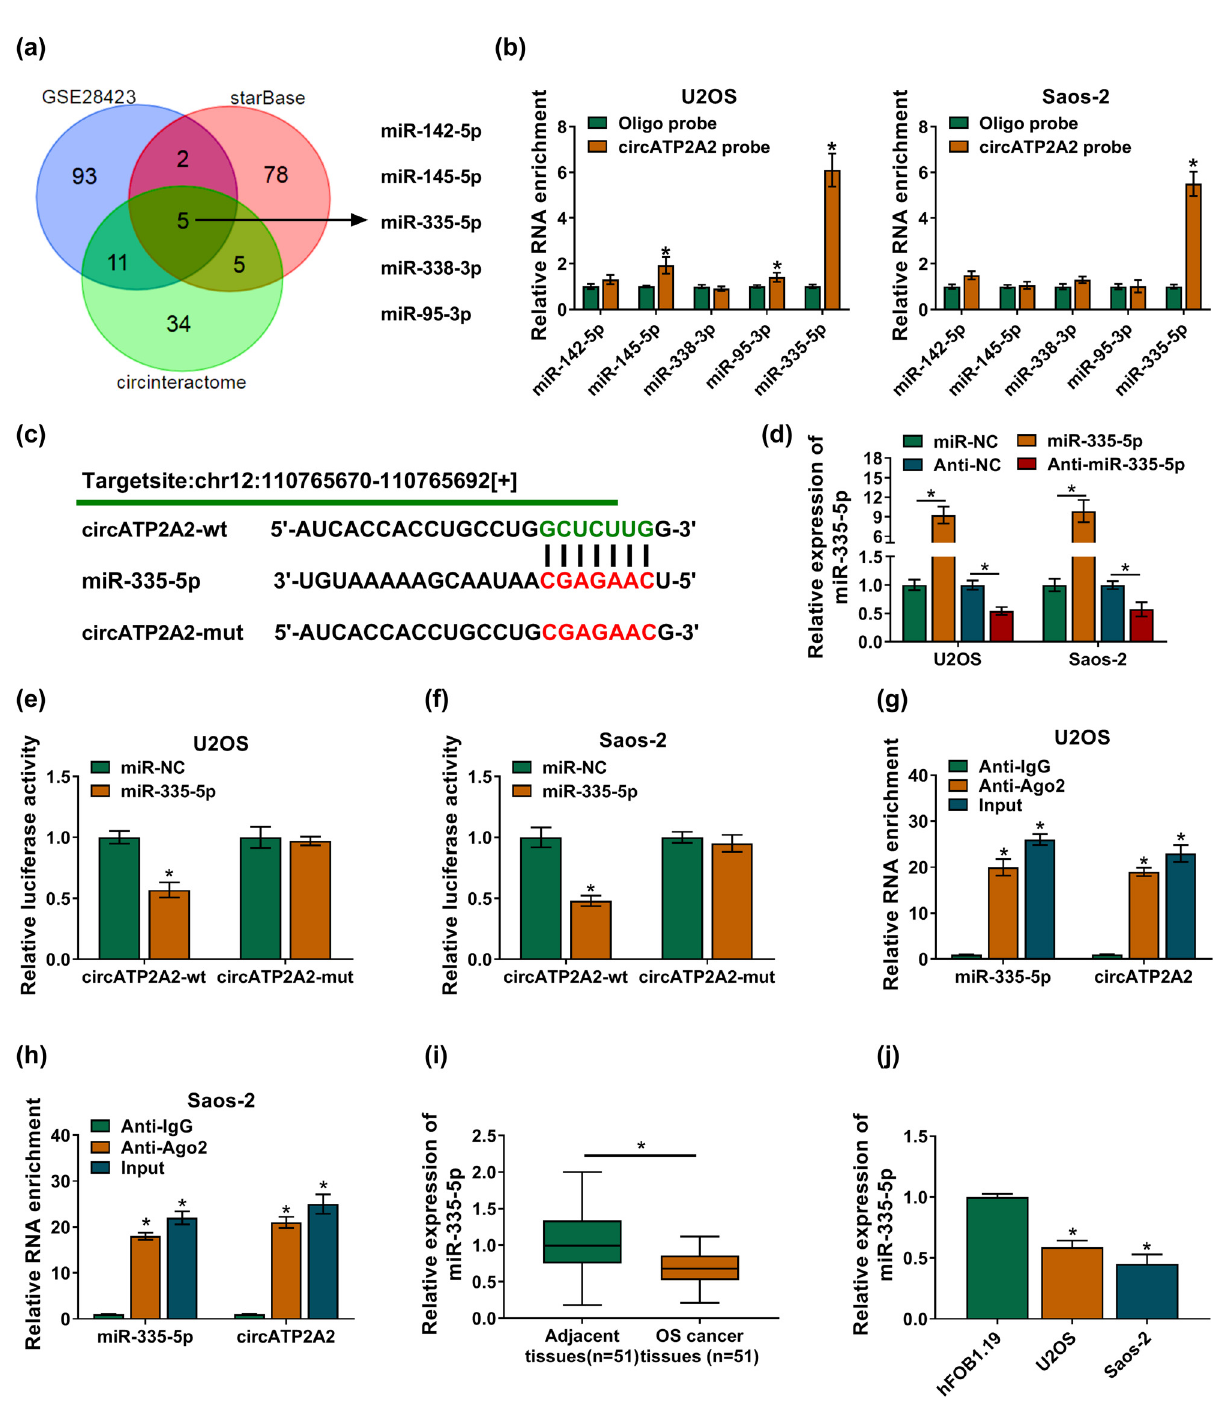
Figure 3: circATP2A2 was veri fi ed as a miR - 335 - 5p sponge. ( a ) The candidate miRs containing the putative binding sites of circATP2A2 were overlapped in circinteractome, starBase, and GSE28423 databases. ( b ) The abundance of candidate miRs in the oligo probe and circATP2A2 probe groups was detected by RT - qPCR. ( c ) The putative binding sites of circATP2A2 on the miR - 335 - 5p seed sequence. ( d ) The over - expression and interference e ffi ciencies of miR - 335 - 5p and Anti - miR - 335 - 5p were analyzed by RT - qPCR. ( e and f ) The luciferase activity of circATP2A2 - wt or circATP2A2 - mut reporter in OS cells was assessed by dual - luciferase reporter assay. ( g and h ) The enrichment of miR - 335 - 5p and circATP2A2 in co - immunoprecipitated in the anti - Ago2 and anti - IgG groups was analyzed by RT - qPCR. ( i and j ) The expression of miR - 335 - 5p in OS tissues and cells was detected by RT - qPCR. * P <